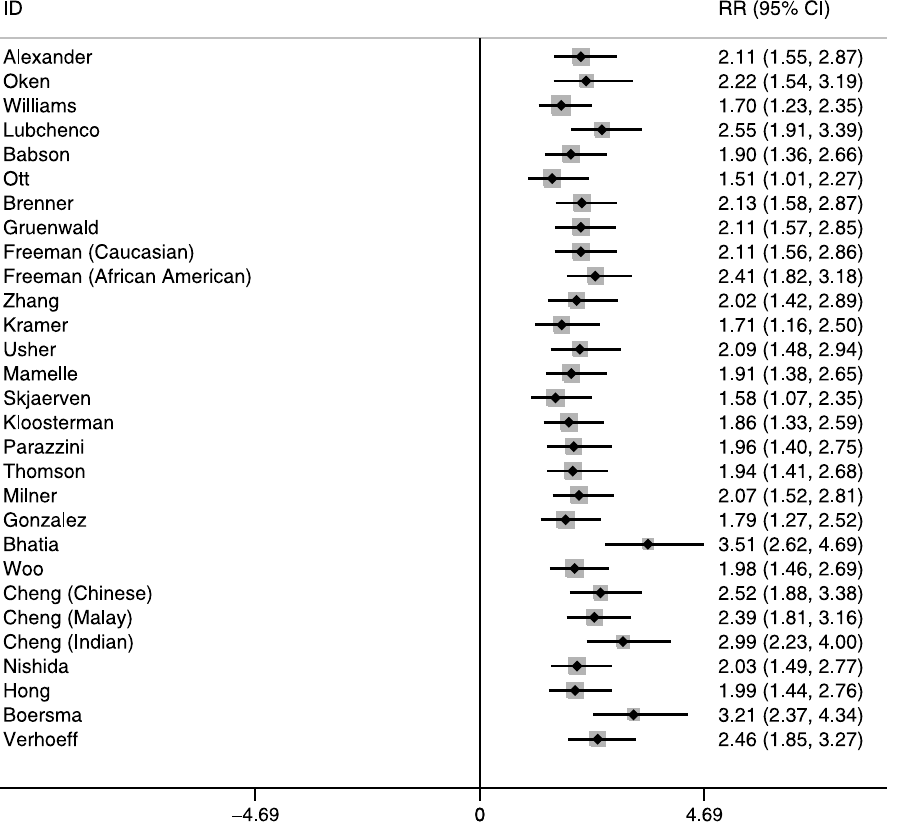
Figure 1. Risk ratios for Term-Small-for-Gestational-Age, Neonatal Mortality: Southern Nepal (reference: Term-Appropriate-for- Gestational-Age).